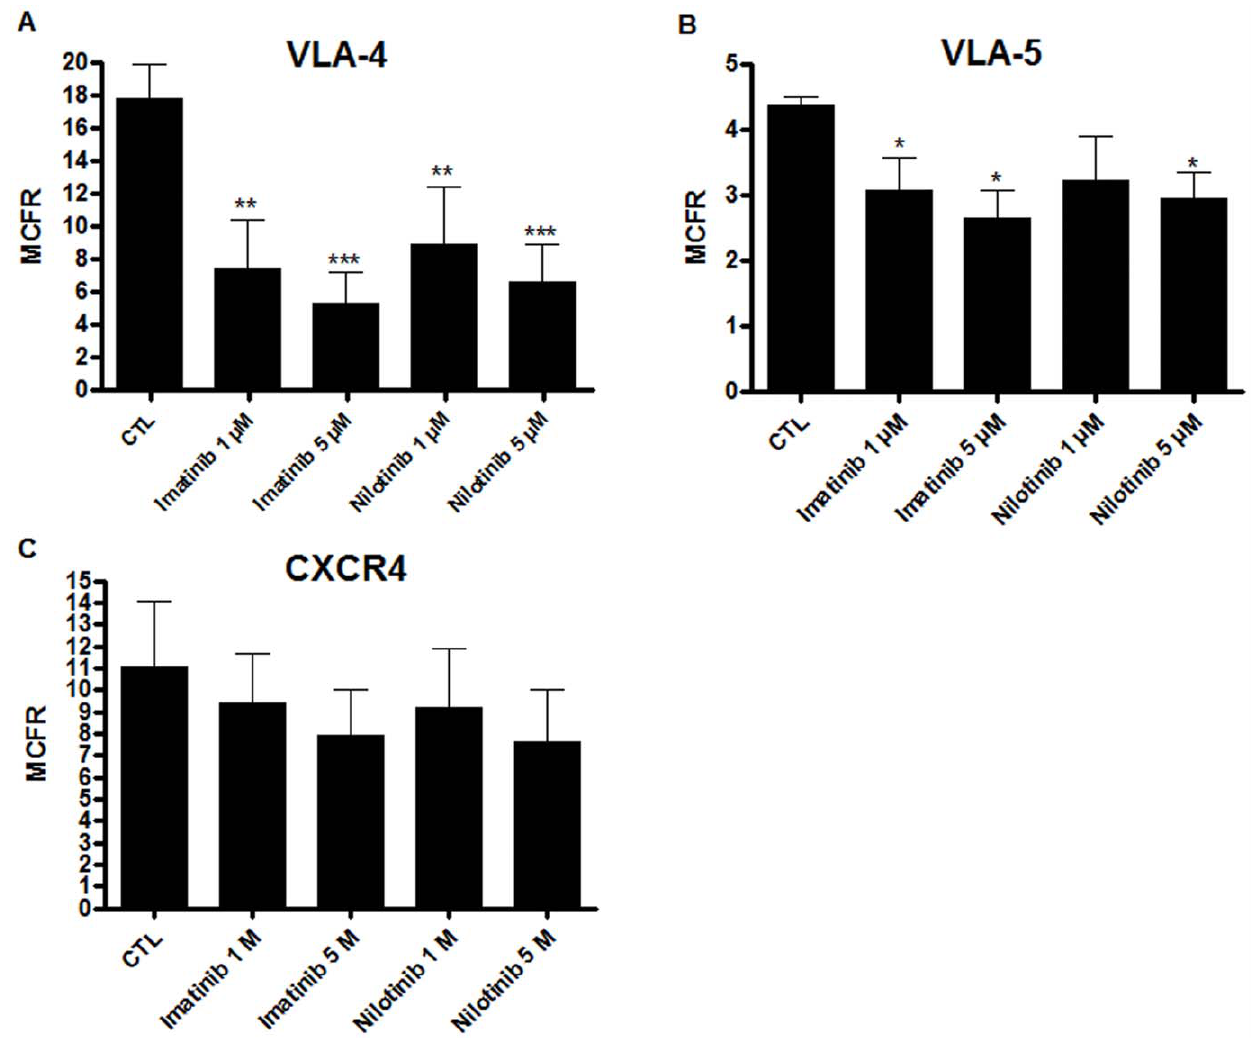
Figure 5. Cell surface expression of VLA-4 and VLA-5 were decreased after a 48 h cell-culture with TKIs while CXCR-4 expression was not affected. Influence of 48-hour pre-culture in presence of either imatinib or nilotinib on ( A ): VLA-4 ( B ): VLA-5 and ( C ): CXCR-4. Results are expressed as the mean channel fluorescence ratio (MCFR) 6 SD. n $ 3, *p , 0.05, **p , 0.01, ***p , 0.001 versus CTL, Student’s paired t tests. CTL: control condition without